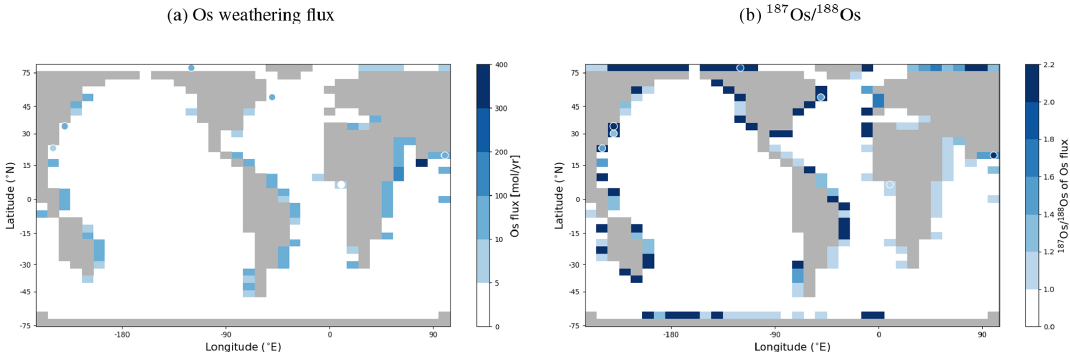
Figure A1. Spatially explicit Os weathering flux using the ROKGEM 2D weathering scheme “GEM_CO2” and observed Os river fluxes (colored dots) based on measured Os concentrations (a) and their isotopic composition (b) in rivers (Levasseur et al., 1999) and annual river runoff (Milliman and Farnsworth, 2013).